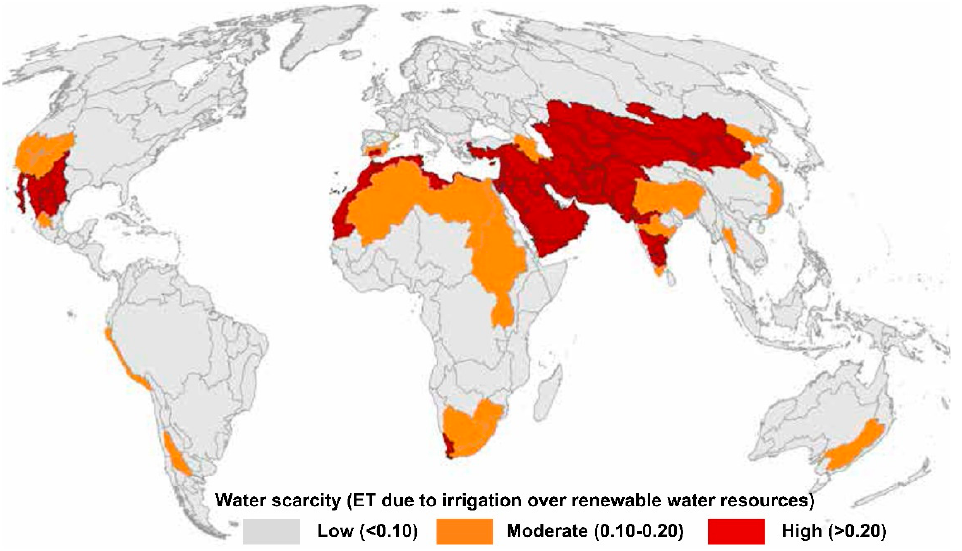
Figure 1. Global map of physical water scarcity by river basin [1].